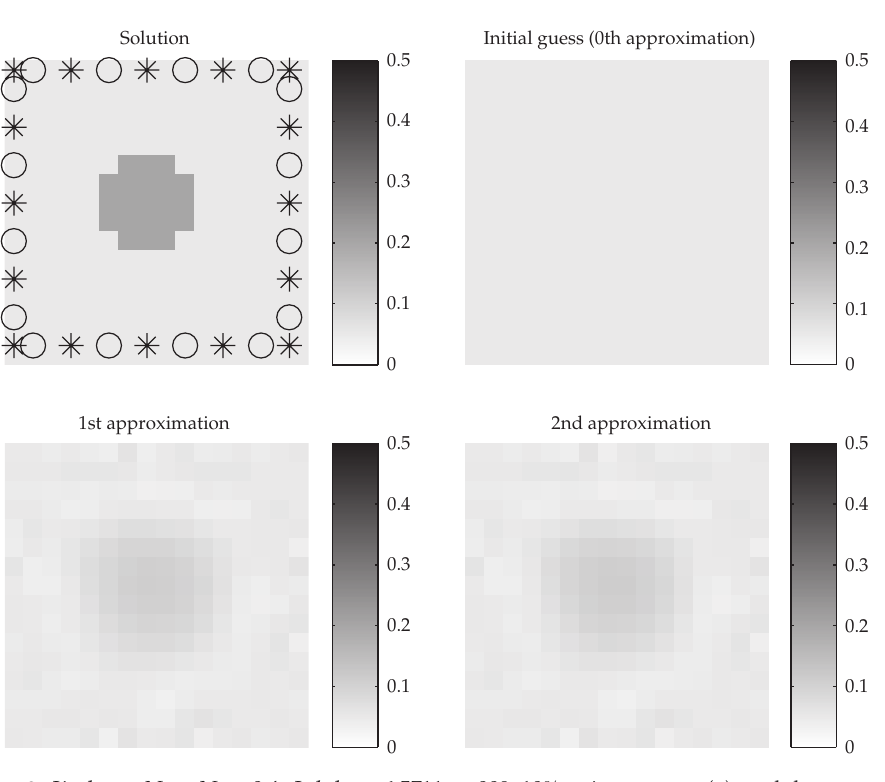
Figure 2: Jindex (cid:10) Nx ∗ Ny ∗ 0 . 4, Jalpha (cid:10) 6 . 5711 e − 009, 10% noise, sources (cid:6) ∗ (cid:8) , and detectors (cid:6) o (cid:8)